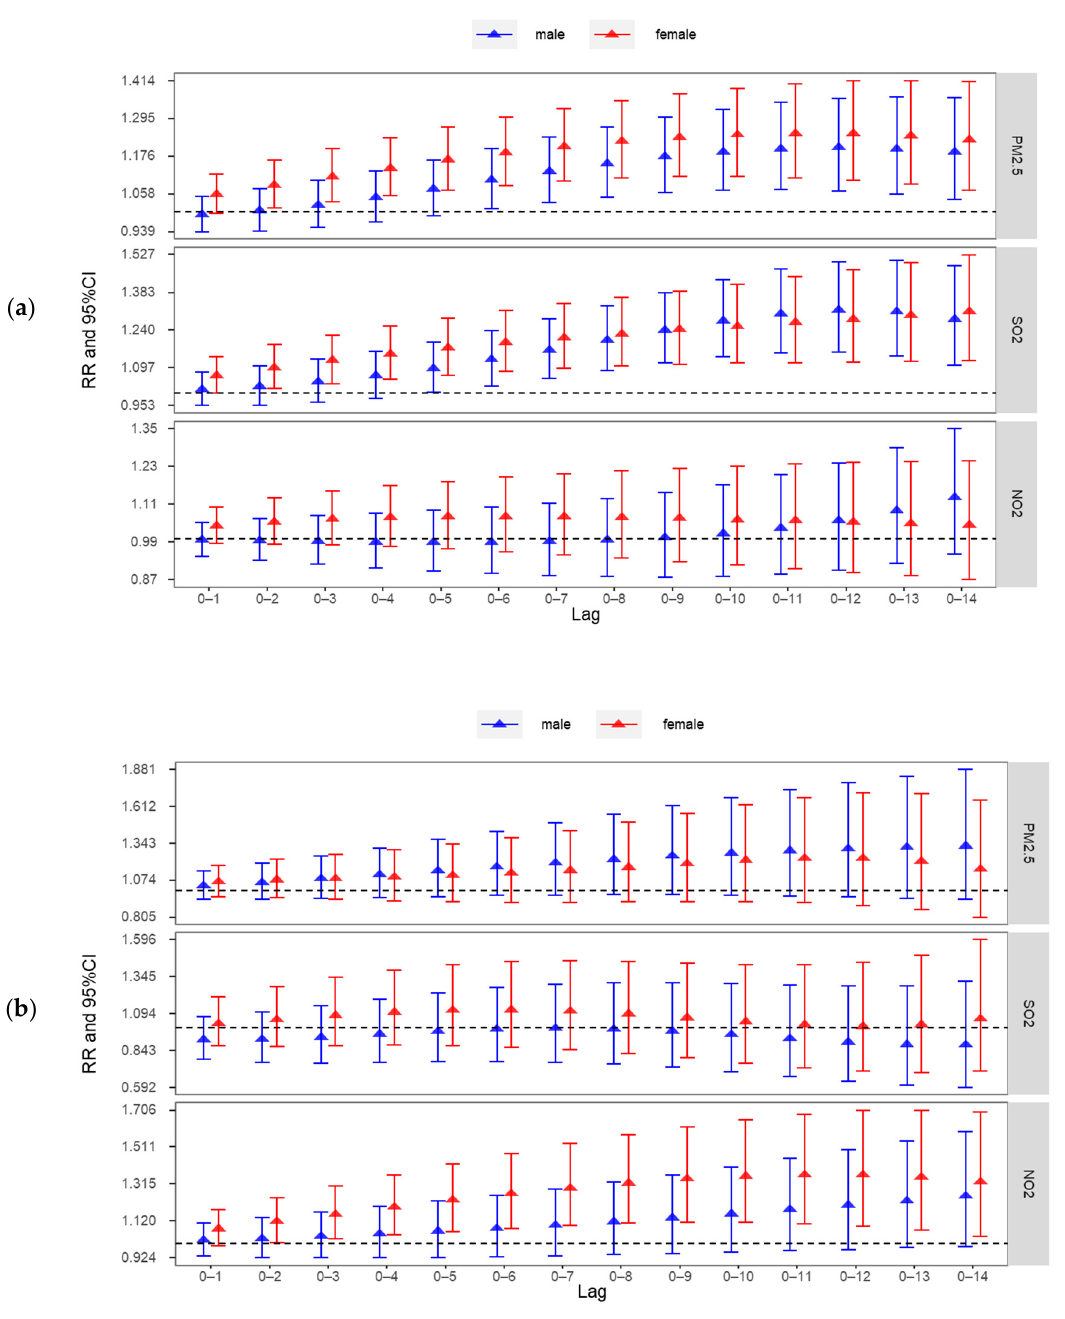
Figure 2. The cumulative lag effects of ambient pollutants on outpatient visits for pneumonia cases by gender. Note: After adjusting for long-term trends, day-of-the-week effects, and meteorological factors, the distributed lag nonlinear model (DLNM) was used to obtain the cumulative lag effects, with the first percentile concentration of air pollutants as the reference. ( a ): The moderate levels. ( b ): The high